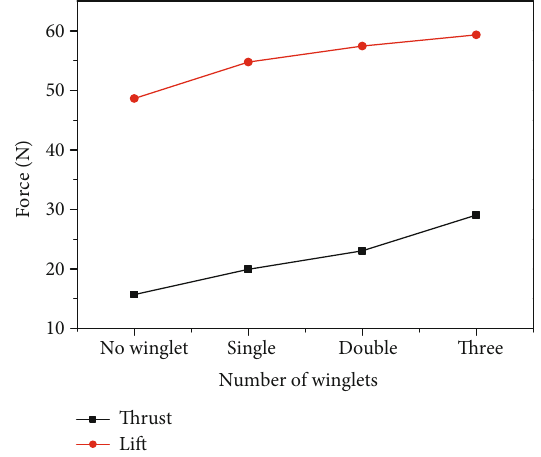
Figure 23: The lift/thrust relationship of di ff erent number of leading edge winglets.